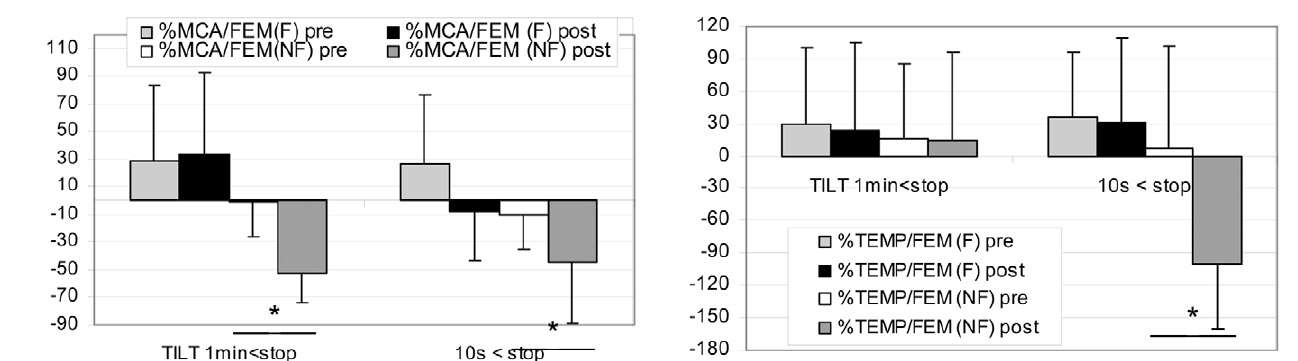
Figure 6. Percent change in Cerebral/Femoral flow ratio at 1 min and 10 s before end of Tilt in F (finisher n=17) and NF (non finisher n=4). Similar change pre and post HDBR at 1 min and 10 s. (mean + / 2 SD, * P , 0.05).